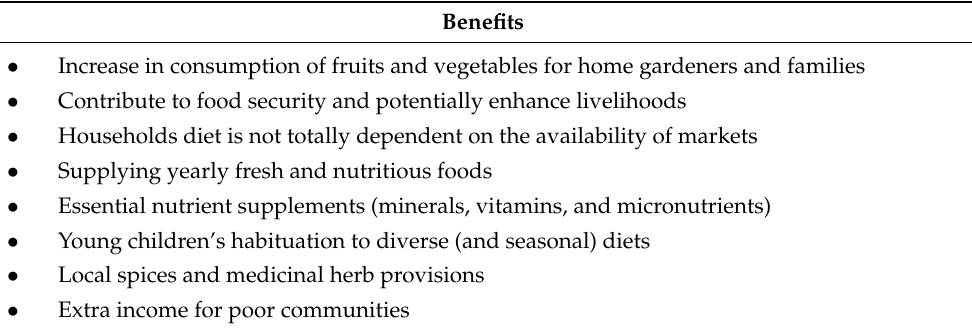
Table 2. Benefits, pursuits, and encouragement of home gardening related to human diet.